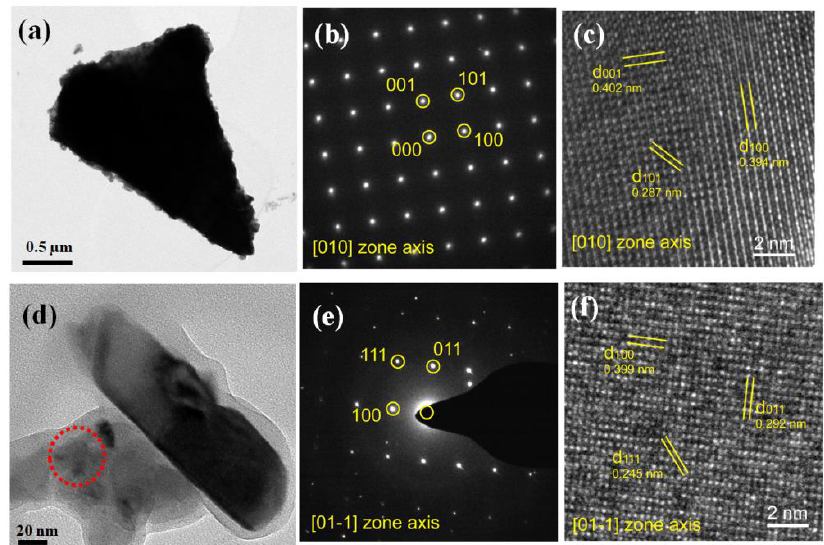
Figure 4. HRTEM images and SAED patterns of the coarse grain ( a – c ) and small grain ( d – f ). The bimodal structured KN-BT(9/1) bulk ceramic sintered at 1050 °C was selected for the analysis. Notes: the lattice planes 001, 101, 100 in [010] zone axis respectively in ( b ); as well as the lattice planes 111, 011, 100 in [01‒1] zone axis respectively in ( e ).